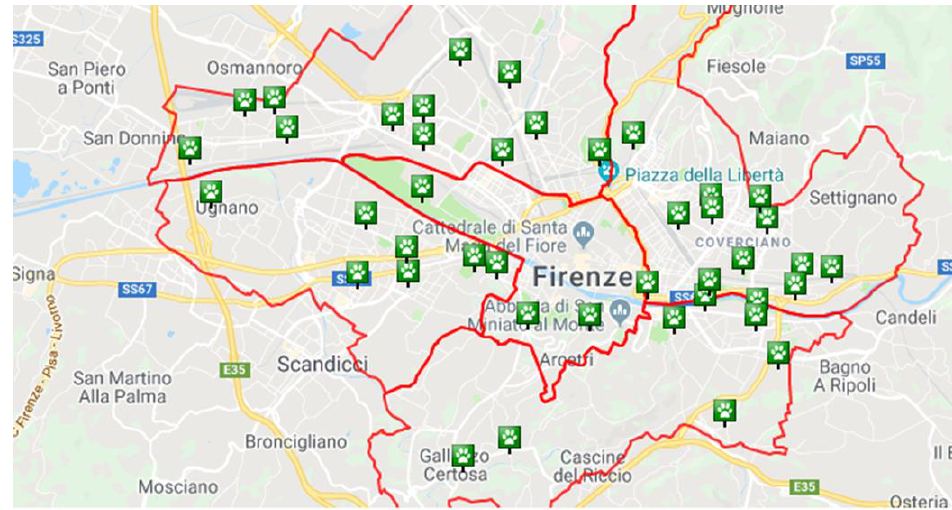
Figure 2. The distribution of the canine off-leash parks in the urban